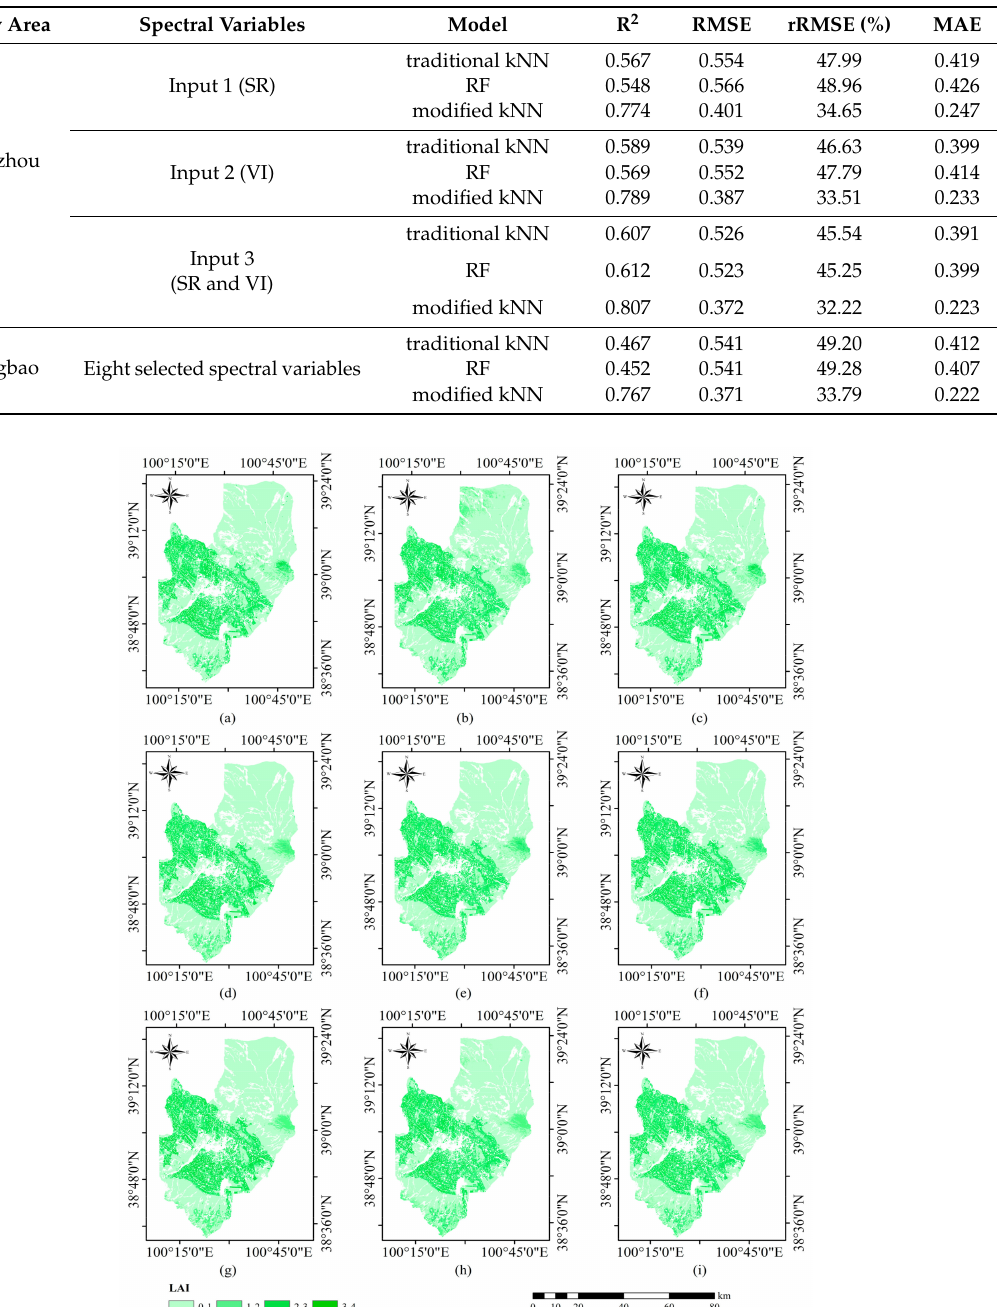
Table 4. The LAI prediction accuracies of the k-nearest neighbors (kNN), RF, and modified kNN in Ganzhou and Kangbao.